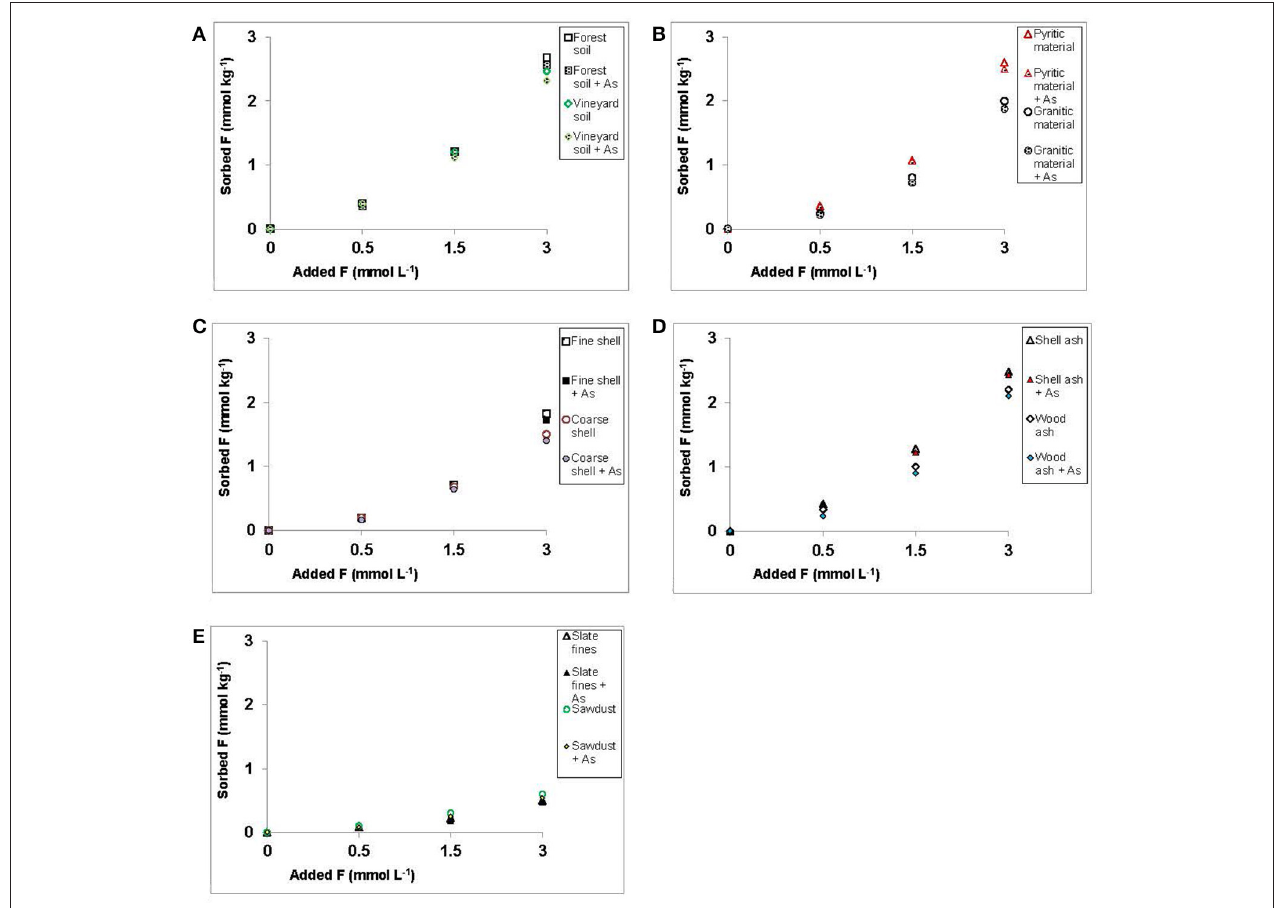
FIGURE 4 | Sorption results (mmol kg − 1 ) for F − on the soils, by-products and waste materials studied, for increasing F − concentrations added, both in absence of As(V) or when 3 mmol L − 1 of As(V) are added. Average values (three replicates), with coefficients of variation < 5%.